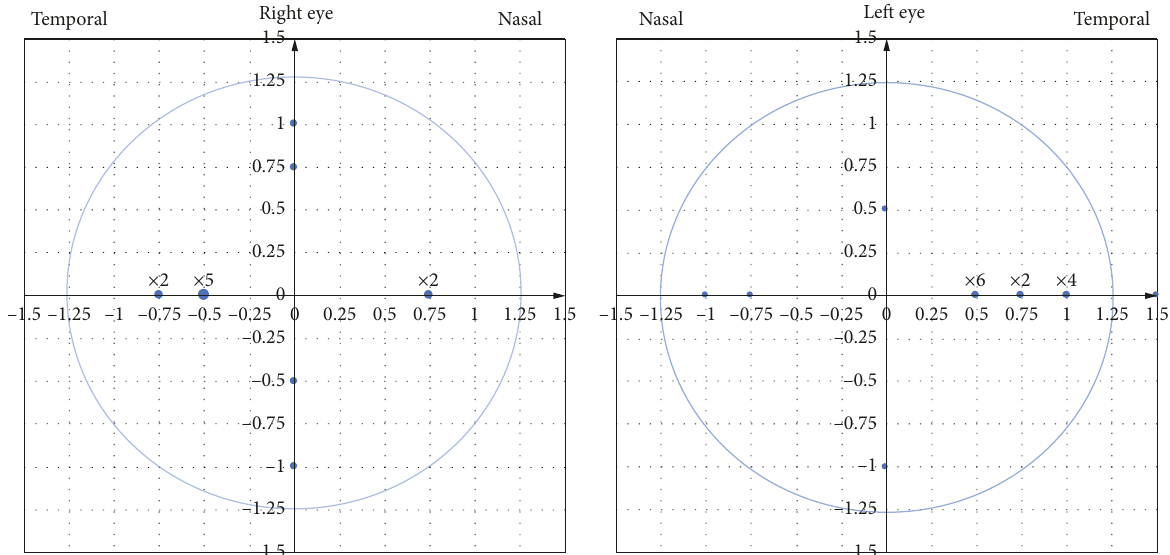
Figure 3: The position of lens fitting among 30 OLD eyes. Each lattice represents 0.25mm on corneal and the symbol of × 2 means there are two cases of this position, and so